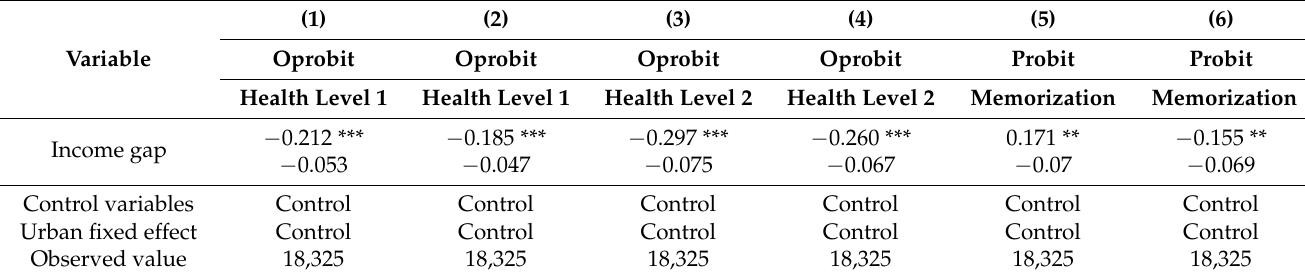
Table 4. The impact of income gap on different health